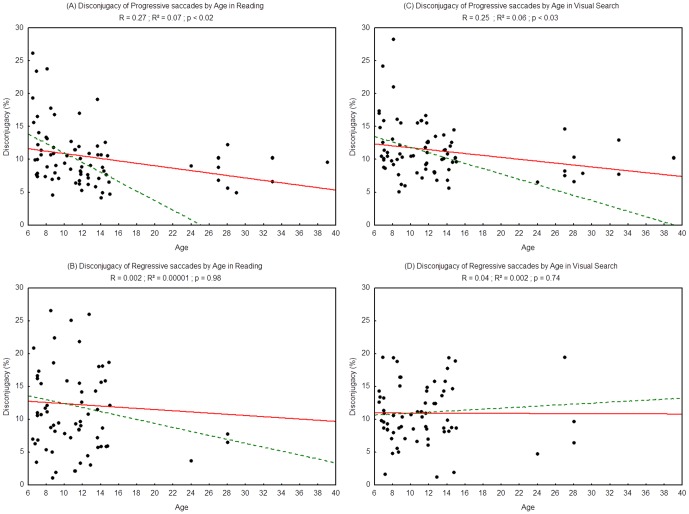
Saccadic disconjugacy of progressive saccades in the reading (A) and visual search tasks (C) and disconjugacy during the regressive saccades in the reading (B) and visual search tasks (D).Lines represent the corresponding regressions. Dotted lines represent the regressions for children only (from 6 to 15 years old), 2A: R2 = 0.11, p<0.006; 2B: R2 = 0.006, p = 0.53; 2C: R2 = 0.07, p<0.03; 2D: R2 = 0.007; p = 0.50.